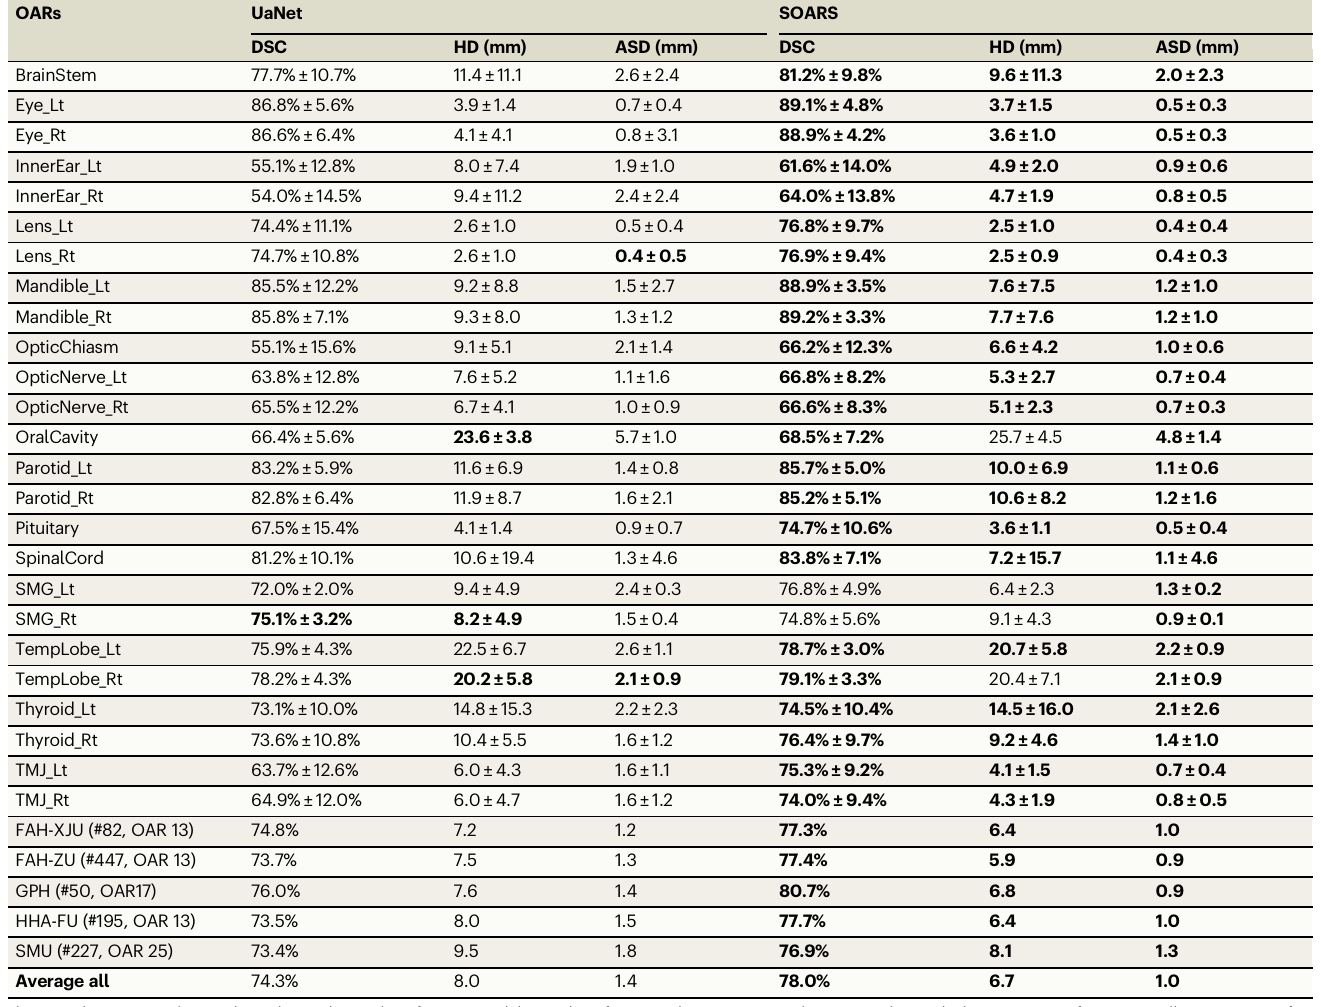
Table 4 | Quantitative comparisons on the external testing dataset of 1001 patient